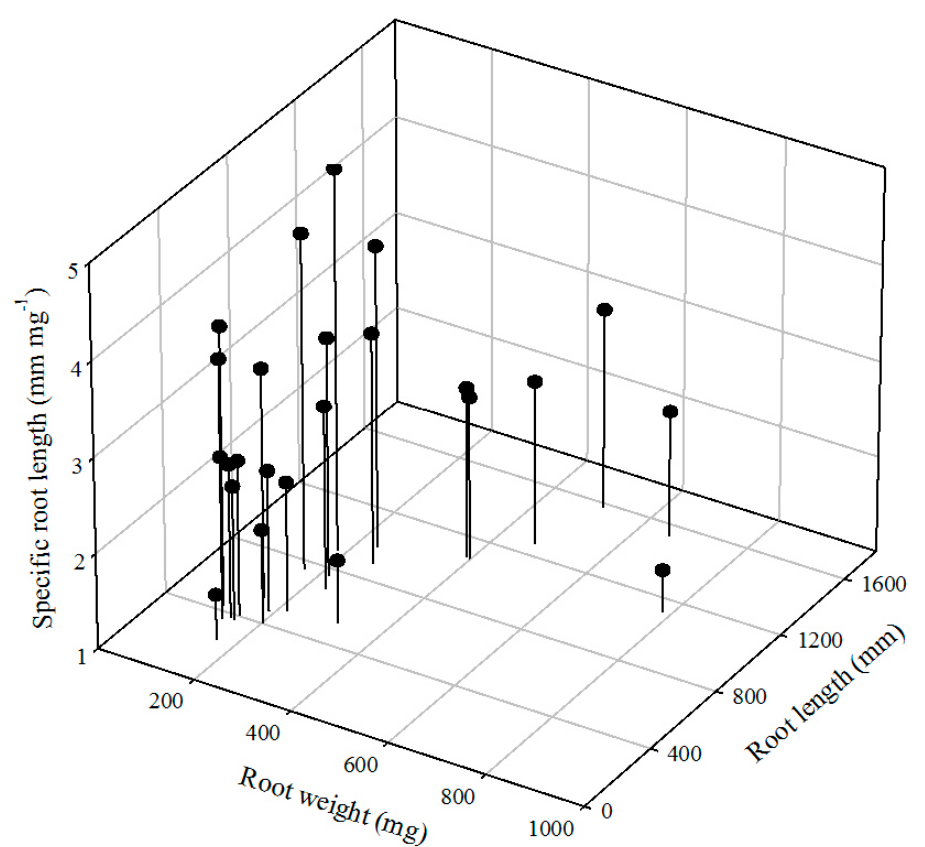
Figure 1. Distribution of root length, root weight and specific root length of hairy vetch after 4 weeks cultivation.